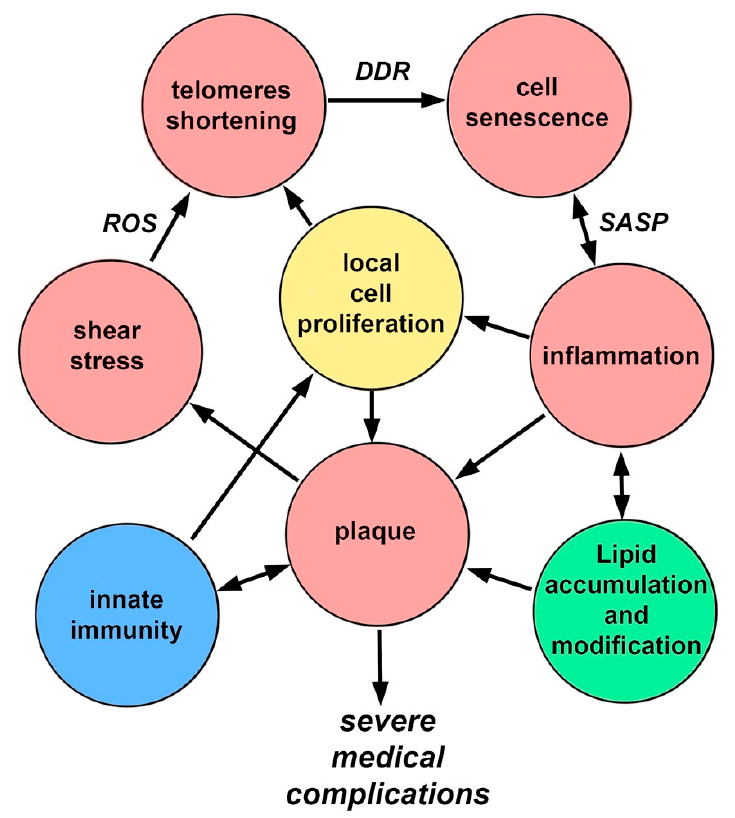
Figure 3. Positive feedbacks in the pathogenesis of atherosclerosis.